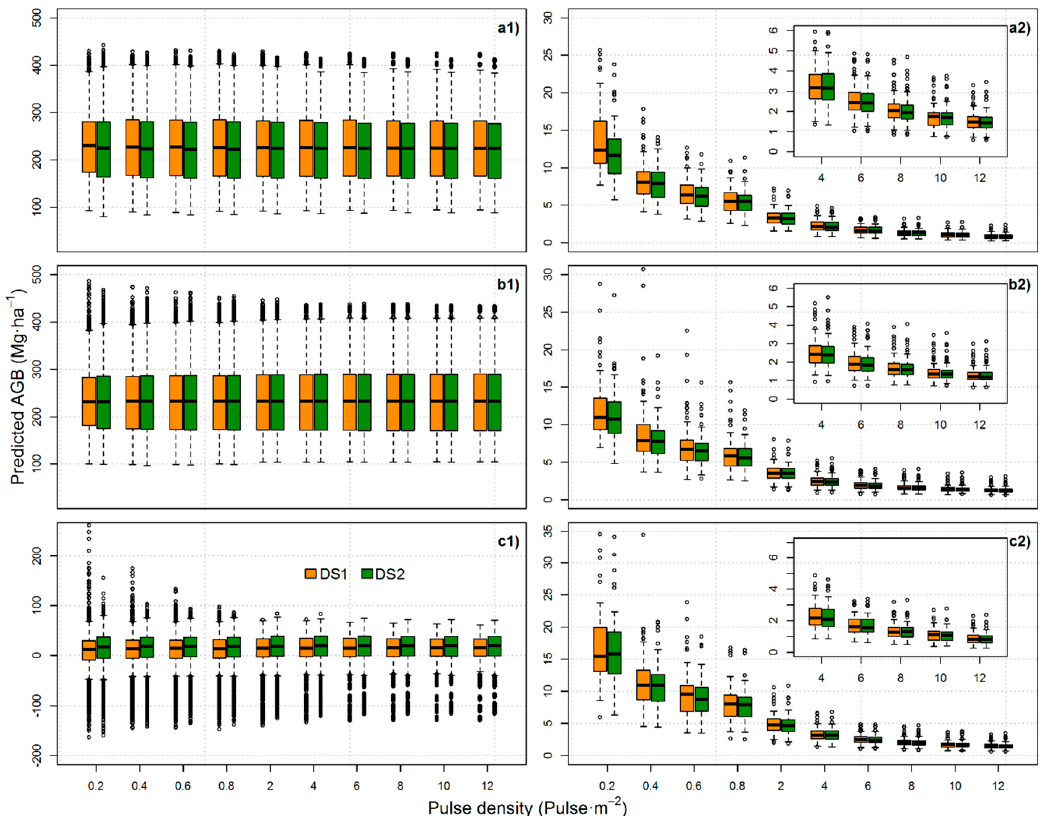
Figure 6. Boxplot of the AGB estimates for 2012 and 2014 ( a1 , b1 ), and AGB change ( c1 ). Standard deviation of AGB stock in 2012 ( a2 ), 2014 ( b2 ) and AGB change ( c2 ) (30 repetitions) ( n = 84).